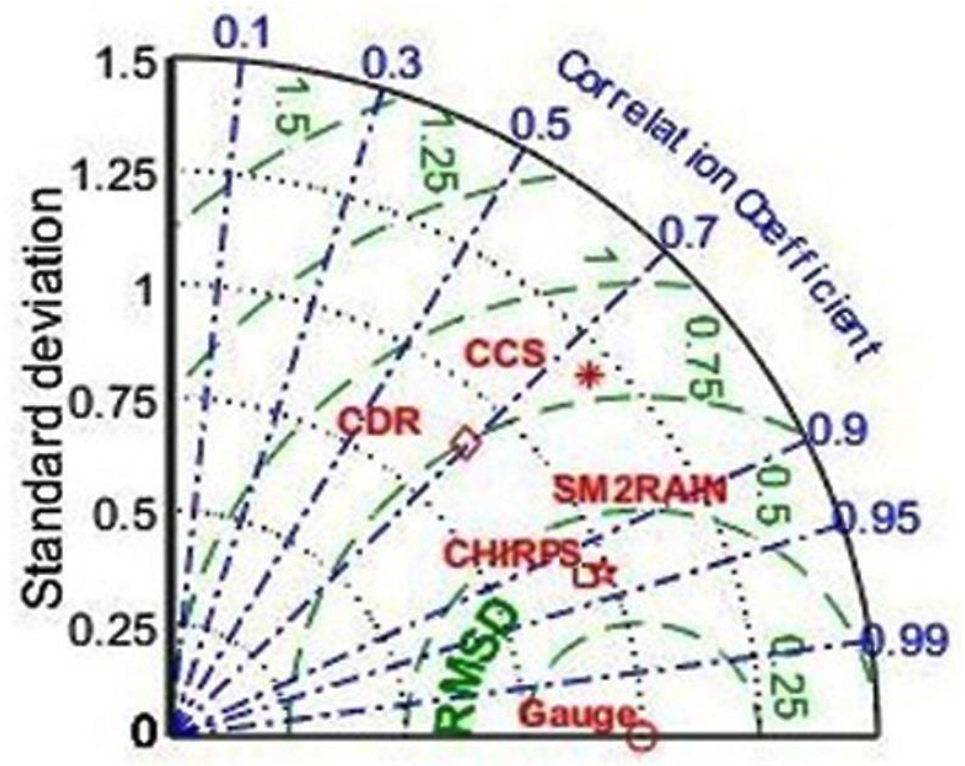
Figure 4. Taylor diagram showing the summary of the performances of the monthly rainfall estimates of SM2Rain-ASCAT, CHIRPS-2.0, PERSIANN-CDR, and PERSIANN-CCS in the Punjab Province of Pakistan. The semi-circular green lines show the values of the RMSE, and straight blue lines show the values of the CC.